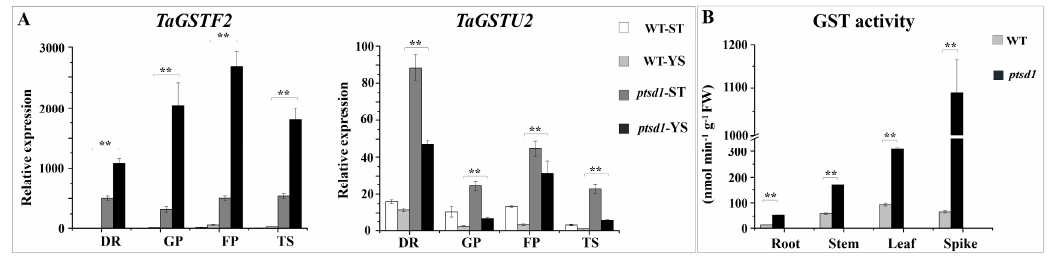
Figure 9. Expression patterns of GST encoding genes and GST activity in WT and ptsd1 . The asterisk indicates the significant difference between different samples (**: p ≤ 0.01).